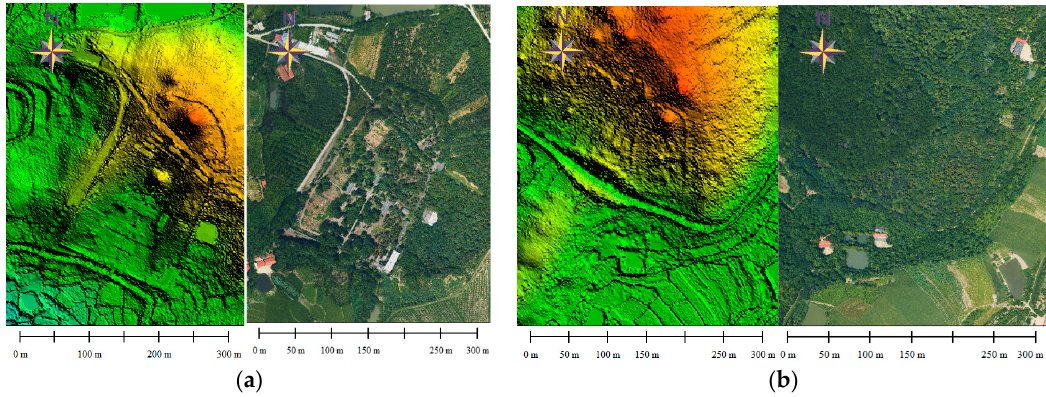
Figure 12. Identification and verification of archaeological remains. ( a ) Road across near the mound; ( b ) Road across the bottom of the